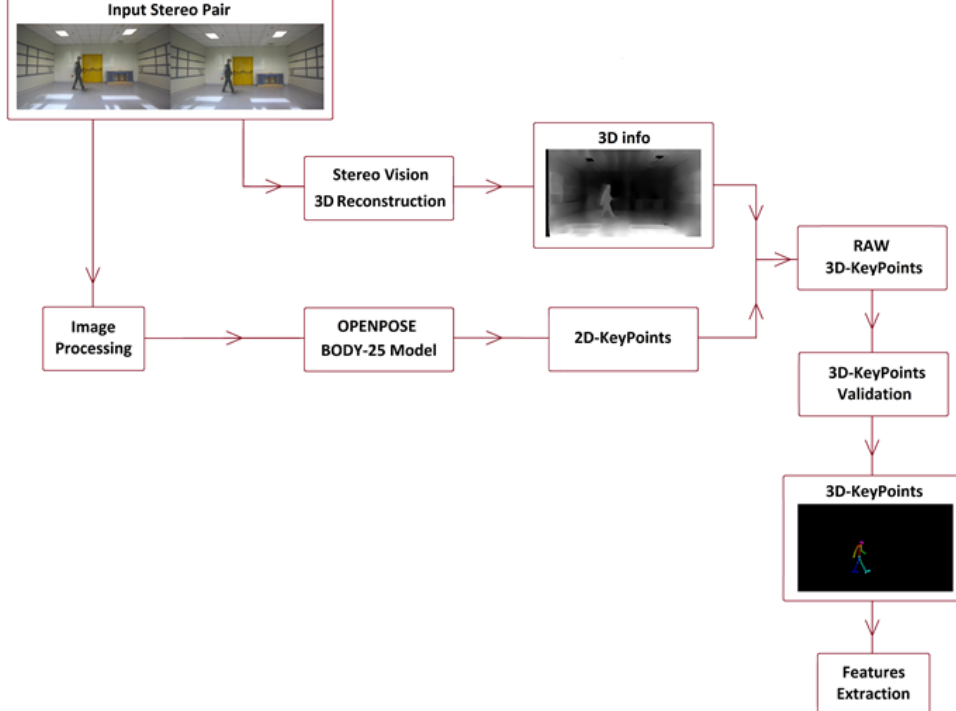
Figure 1. How the system processes input data to obtain the subject’s features.